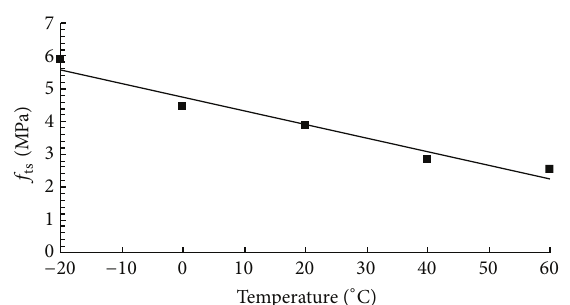
Figure 7: Temperature effect on splitting tensile strength of con- crete.